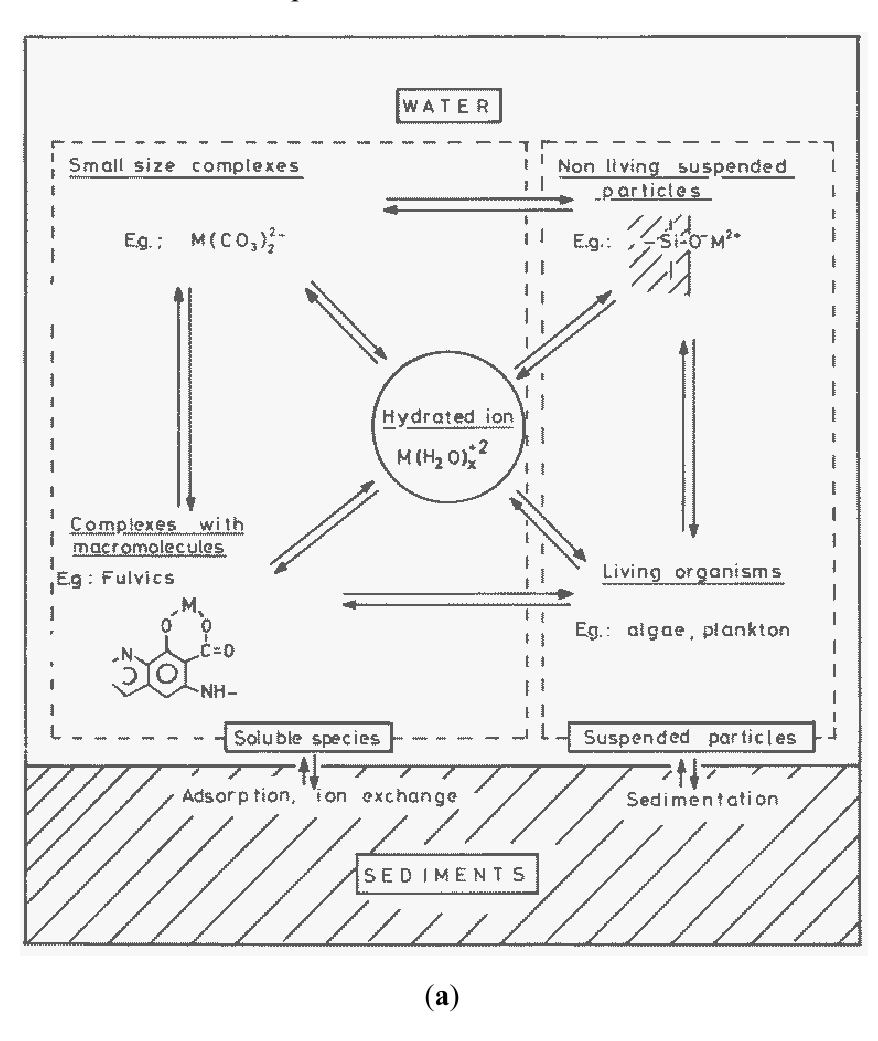
Figure 4. ( a ) Schematic representation of the interactions of a metal with different types of aquatic systems constituents, reproduced with permission from [49]; ( b ) Proposed new schema that takes into account aspects discussed in the